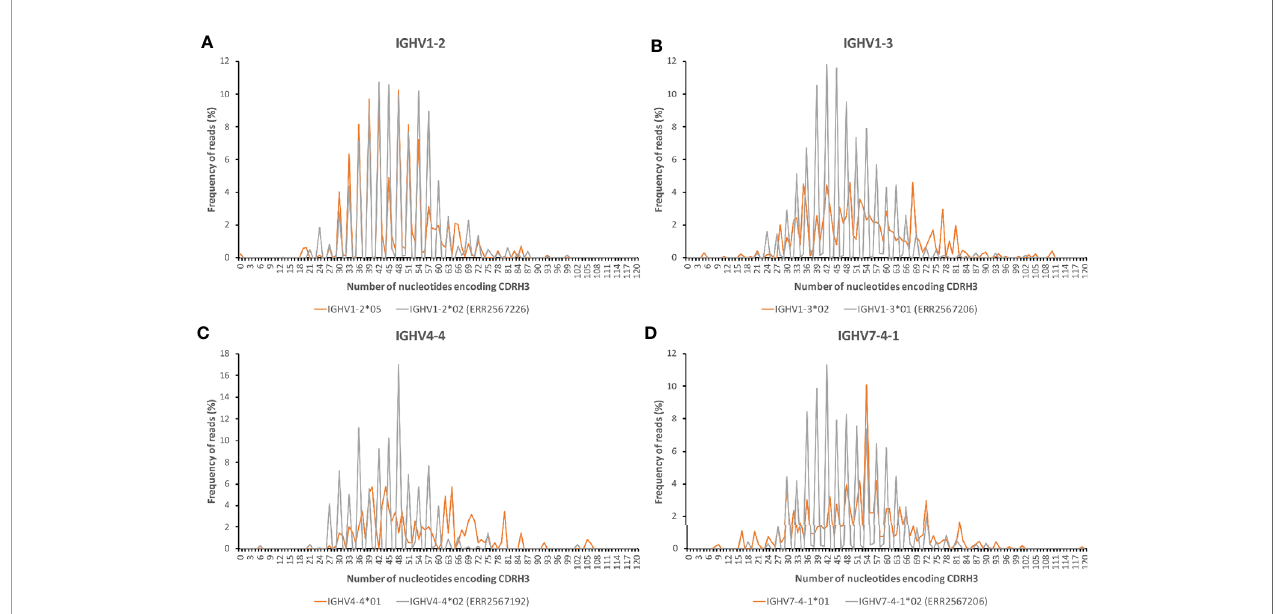
FIGURE 3 | The number of nucleotides of the CDR3-encoding part of reads derived from IGHV1-2*05 (A) , IGHV1-3*02 (B) , IGHV4-4*01 (C) , and IGHV7-4-1*01 (D) extracted from all donors that use these genes. The distribution of lengths of bases are compared to those of IGHV1-2*02 (data set ERR2567226), IGHV1-3*01 (data set ERR2567206), IGHV4-4*02 (data set ERR2567192), and IGHV7-4-1*02 (data set ERR2567206),